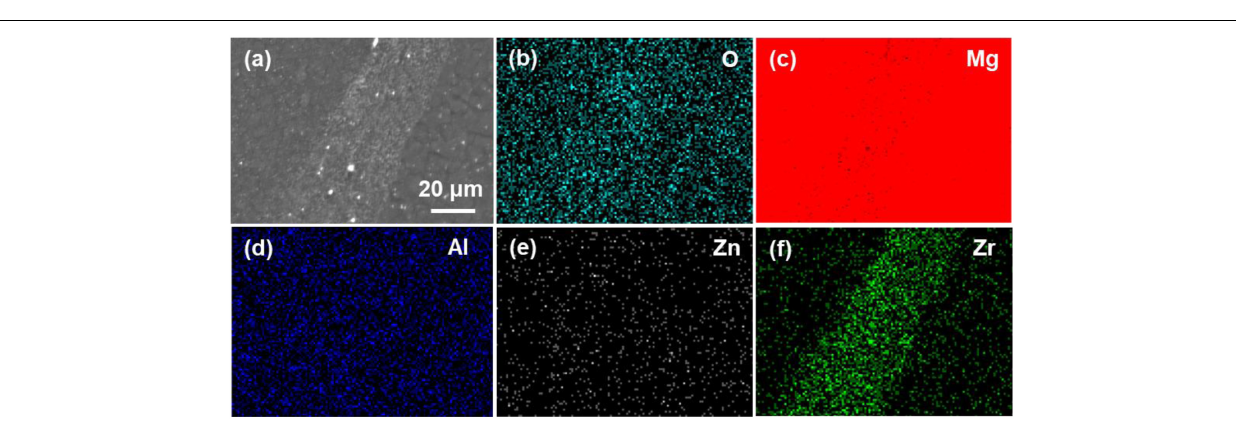
FIGURE 3 | SEM-EDS mapping shows (a) the ZrO 2 particles embedded in matrix (b–f) color mapping of elements O, Mg, Al, Zn, and Zr of the SZ-center in FSPed AZ31/ZrO 2 composite (Z3-2P